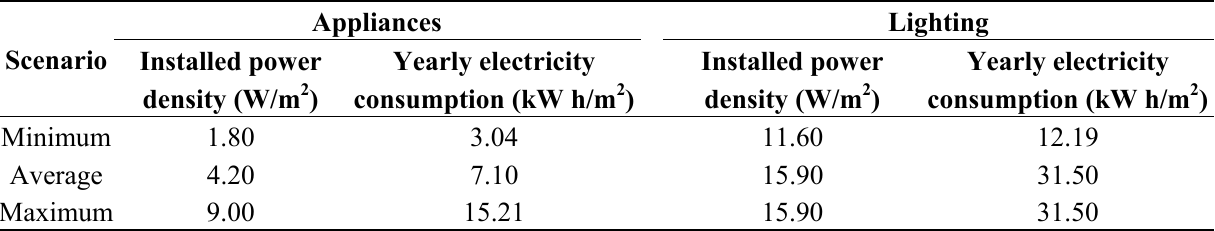
Table 4. Installed power density and yearly electricity consumption for appliances and lighting in office buildings